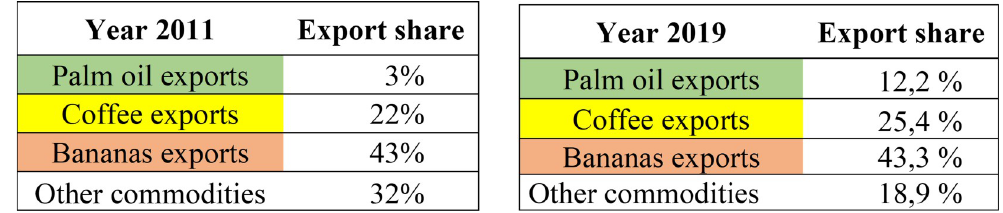
Fig 5. Export value share of Colombian agricultural commodities with the EU. Source: Prepared by the authors, based on data from UN Comtrade [37] and Atlas of economics complexity [31].